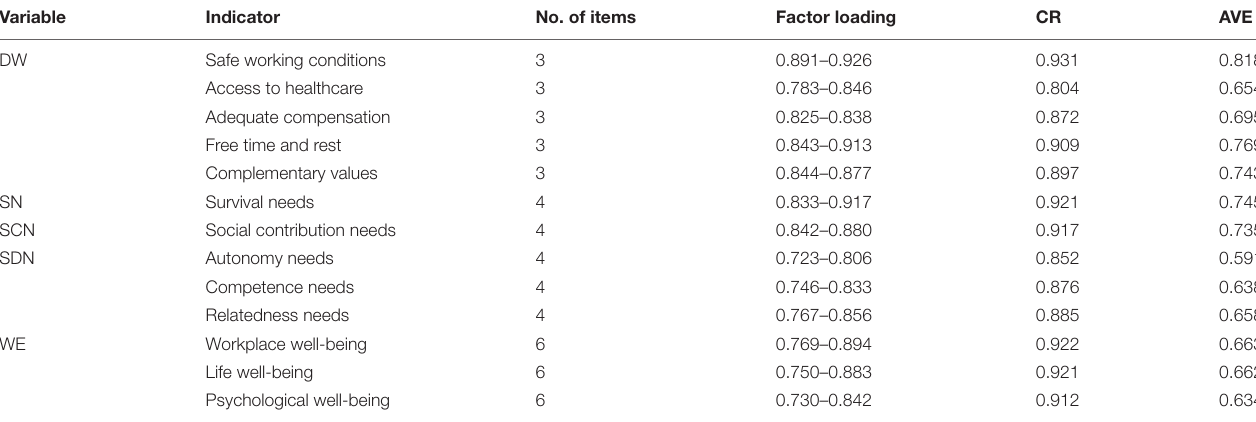
TABLE 2 | Reliability and convergent validity.